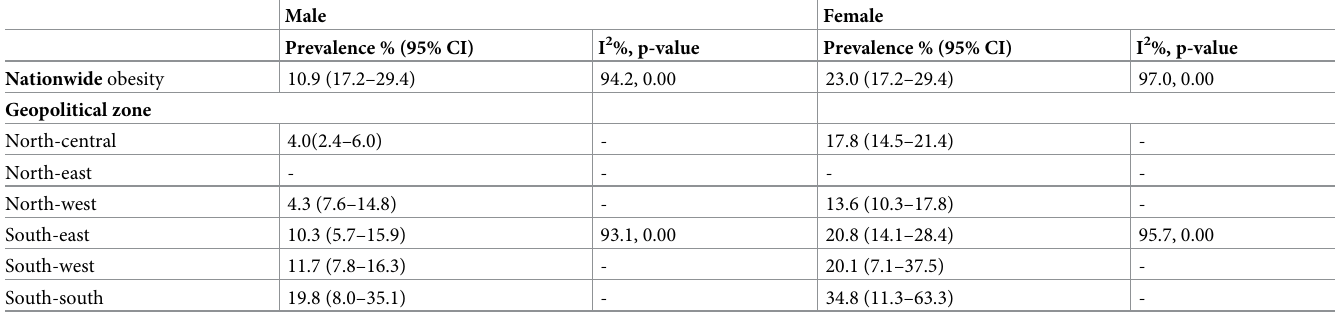
Table 5. Pooled estimates of the prevalence of obesity among men and women in